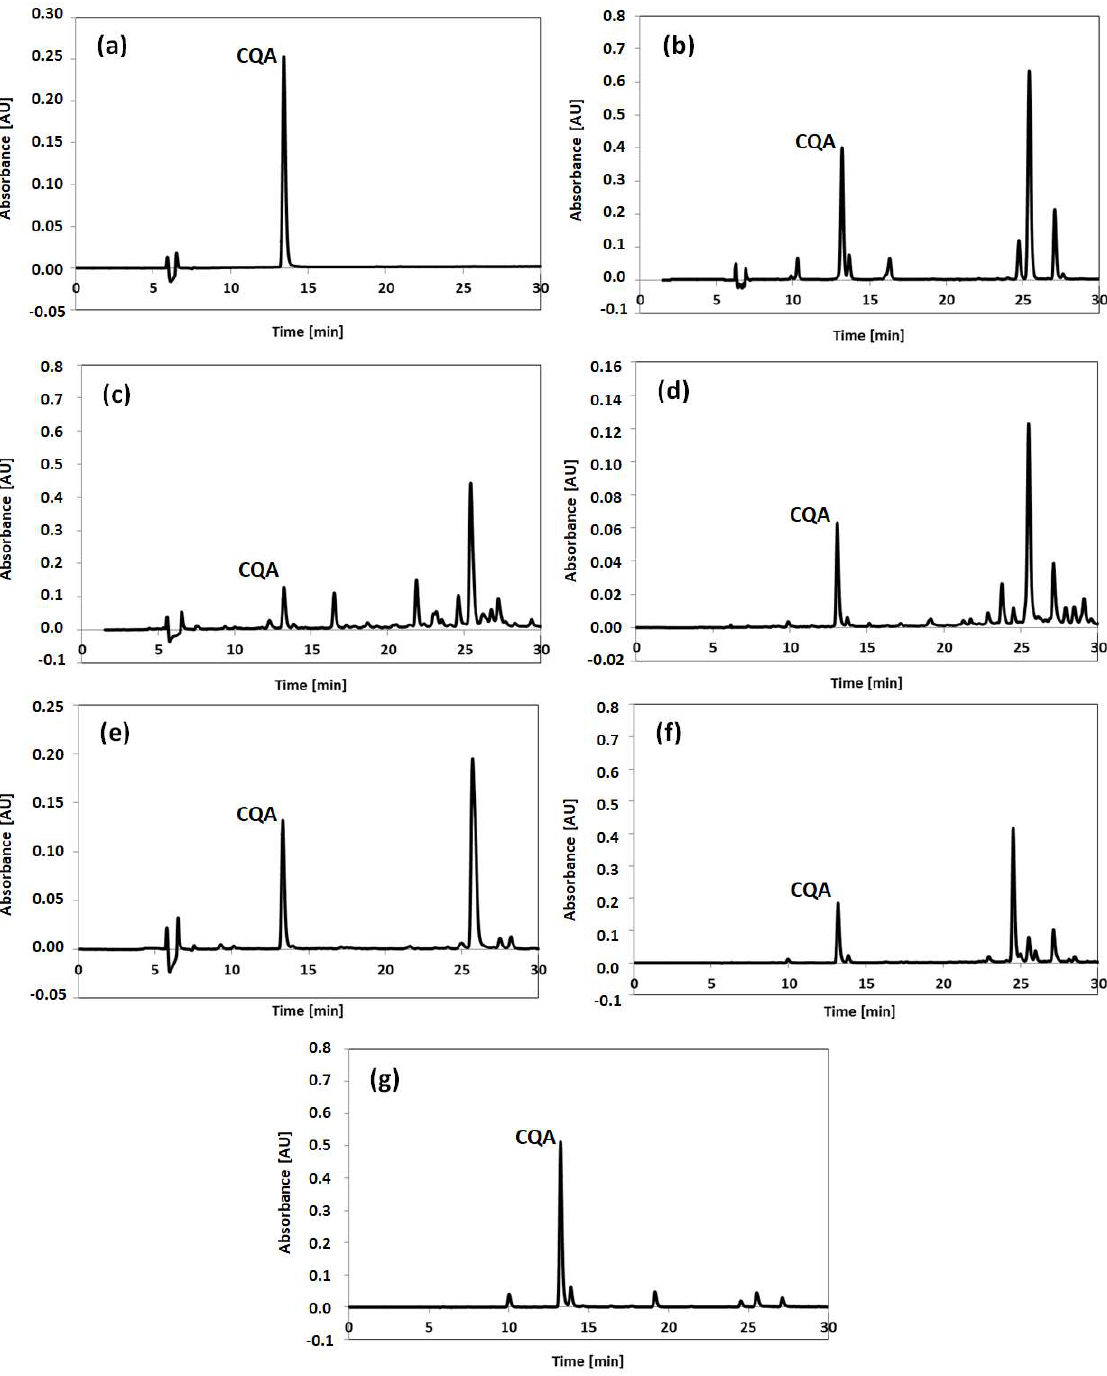
Figure 1. Exemplary chromatograms of the CQA extract after SSDM of the CQA standard ( a ) and water extracts obtained using the SSDM technique from pickled artichoke hearts ( b ), dried chamomile flowers ( c ), tansy ( d ), coltsfoot ( e ), yarrow ( f ) and green coffee beans ( g ).